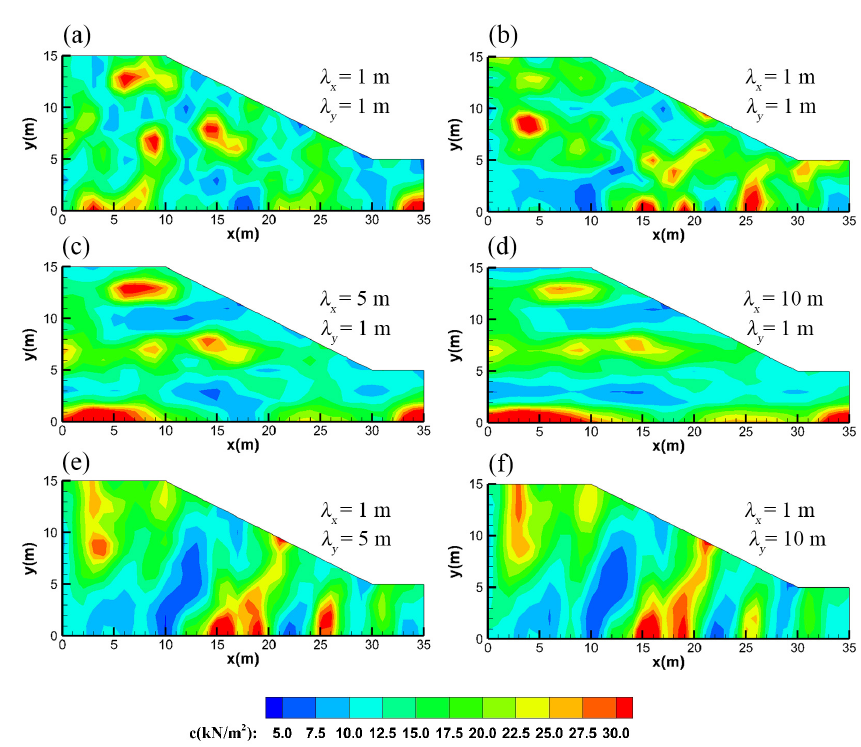
Figure 1. Numerically generated realizations of c in different correlation scales: ( a , b ) λ x = λ y = 1 m, with different random seed, ( c ) λ x = 5 m, λ y = 1 m, ( d ) λ x = 10 m, λ y = 1 m, ( e ) λ x = 1 m, λ y = 5 m, and ( f ) λ x = 1 m, λ y = 10 m.